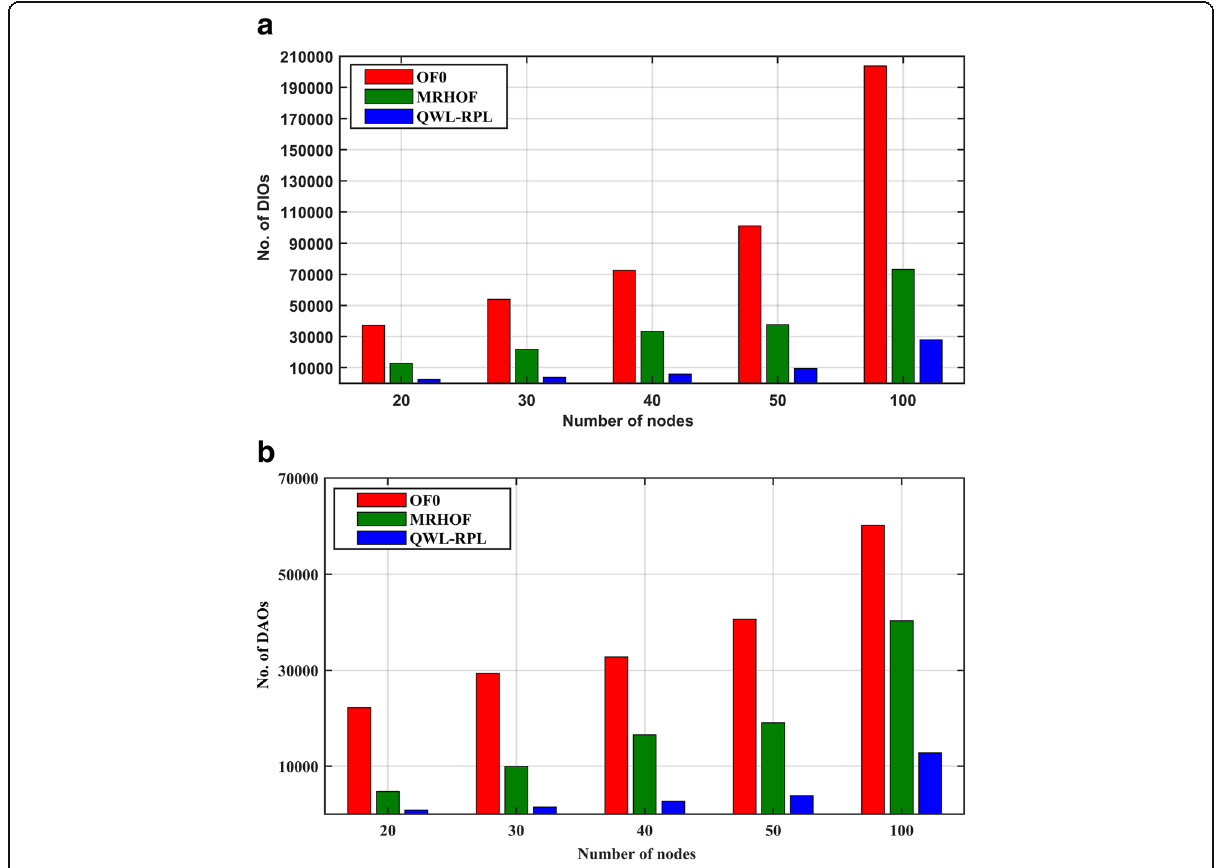
Fig. 11 Simulation analysis for scenario I for the a total number of DIO overheads and b total number of DAOs versus number of